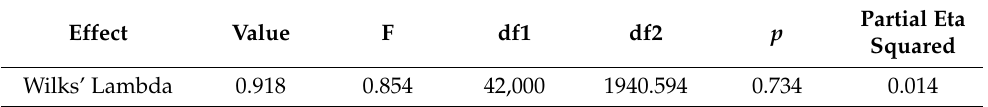
Table 15. Controlling of Bias